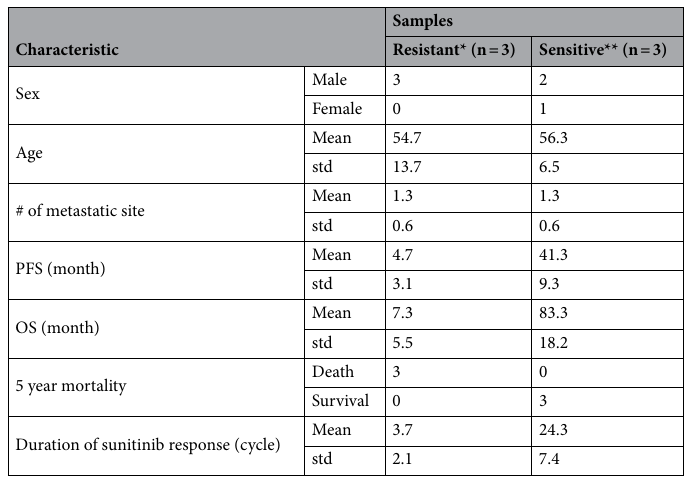
Table 1. Clinical characteristics of 6 CCRCC patients. PFS progression-free survival, OS overall survival. *Resistant: sunitinib-resistant CCRCC patients. **Sensitive: sunitinib-sensitive CCRCC